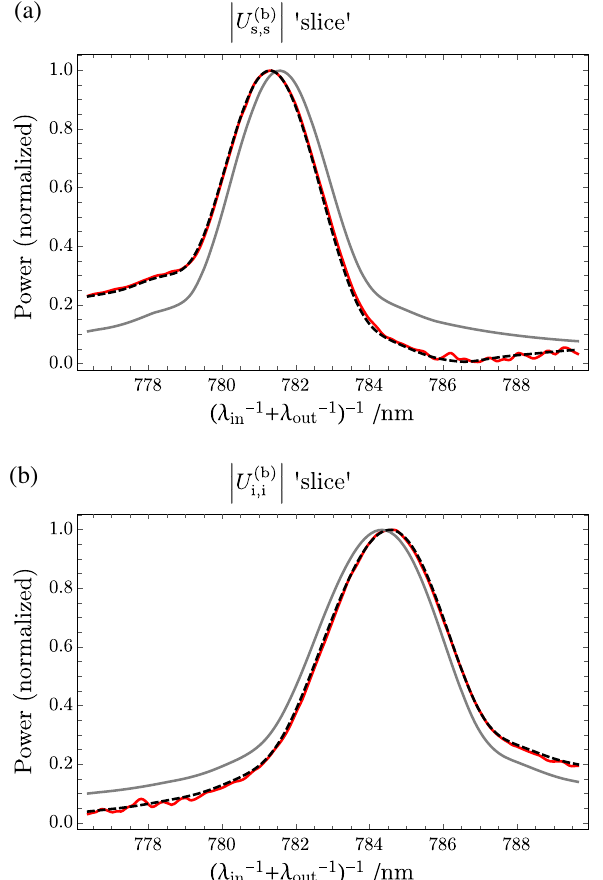
FIG. 4. Same-mode TF slices showing the effect of XPM. The plots show j U s ; s ð i ; i Þ ð λ in ; λ out Þj for λ in ¼ λ out . Red lines: Measure- ð b Þ ment (background subtracted). Black dashed lines: Model pre- diction. Gray lines: Prediction of a model that does not include XPM. The asymmetry arises from superposing the signals generated by cascaded stimulated PDC and